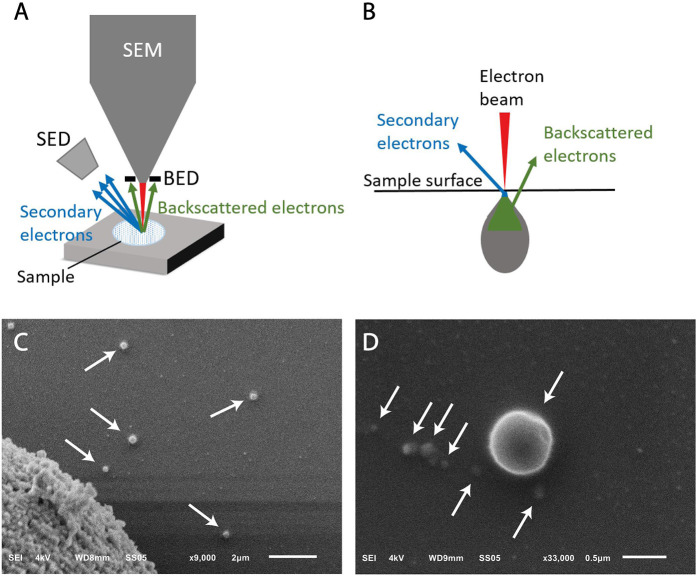
Scanning electron microscopy (SEM) of extracellular vesicle (EV) samples. (A) Schematic representation of a SEM setup. SED, secondary electron detector; BED, backscatter electron detector. (B) The sample is illuminated by the electron beam. Electrons interact with the sample at different depths, resulting in emitted electrons from the surface (secondary electrons) and from deeper layers (backscattered electrons). (C) SEM image of LNCaP EVs indicated by arrows. The large object in the left lower corner is part of a LNCaP cell floating in the cell supernatant and was imaged to show that the contrast of EVs is similar to cells. The scale bar represents 2 μm. (D) Higher magnification allows imaging of smaller particles, possibly EVs, with lower contrast. The scale bar represents 500 nm.